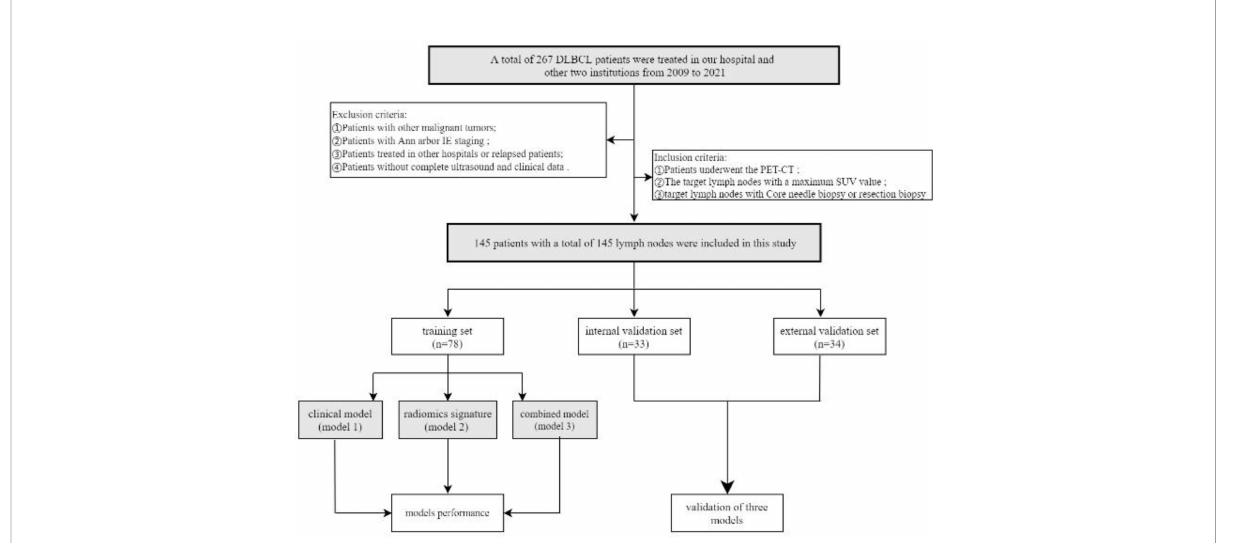
FIGURE 1 Flow chart of patients ’ recruitment pathway. DLBCL, Diffuse large B-cell lymphoma; PET-CT, Positron emission tomography/computed tomography. According to the inclusion and exclusion criteria, 145 patients with a total of 145 lymph nodes were included in this study. The patients of our institutions were randomly assigned to training set(n=78) and internal validation set(n=33) (7:3 ratio). The independent external validation set(n=34) from the other two institutions.